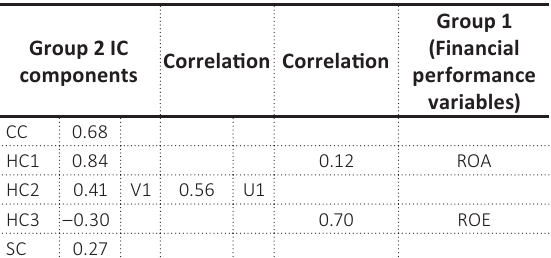
Table 5. CCA of the financial sector